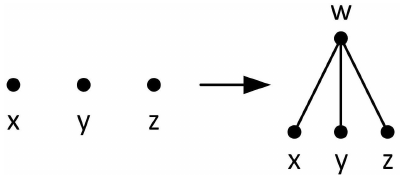
Figure 4. Dawes’ third operation.